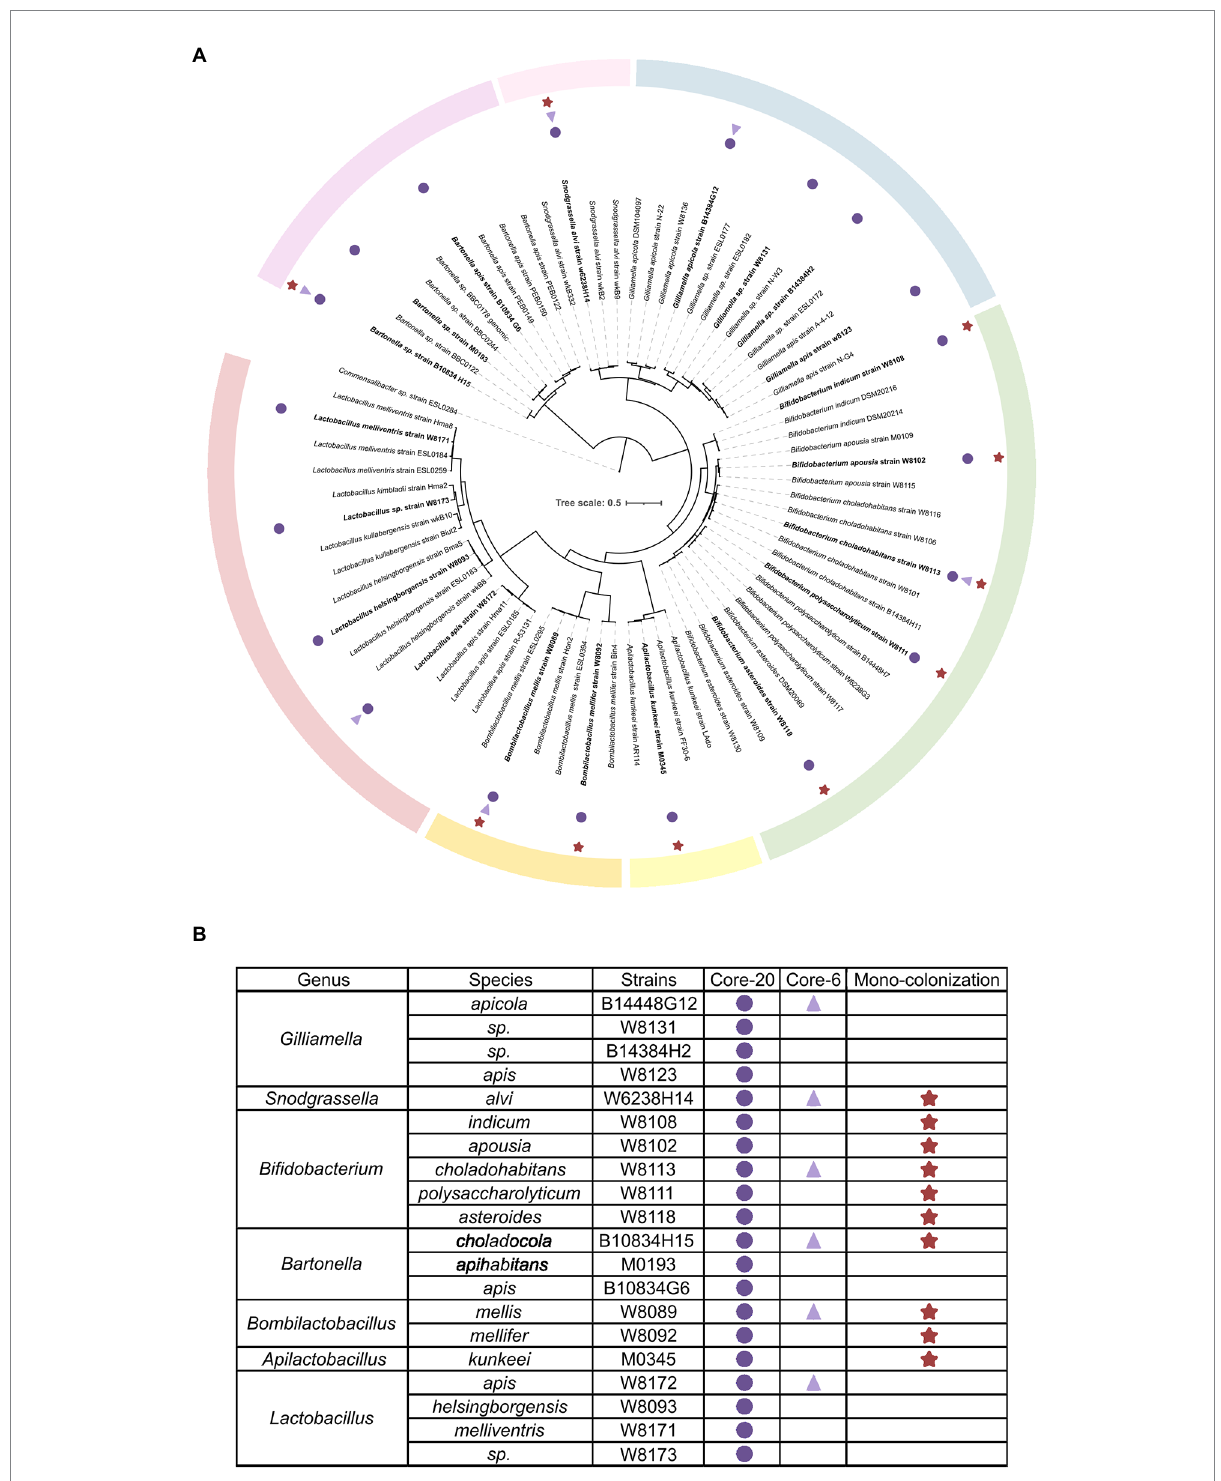
FIGURE 1 Composition of honeybee gut microbiota and strains of the Core-20 and Core-6 community. (A) Maximum-likelihood tree inferred by GTDB-tk based on the amino acid sequences of bacterial marker genes. (B) Detailed information on strain classification and grouping. The Core-6 community consists of six strains representing the six most prevalent and abundant genera of honeybee gut microbiota, and the Core-20 is composed of 20 strains at the species level. Rounds mark the strains of the Core-20, triangles mark the members of the Core-6 and stars mark strains used in the mono-colonization experiments. Color bars indicate the classification of honeybee gut